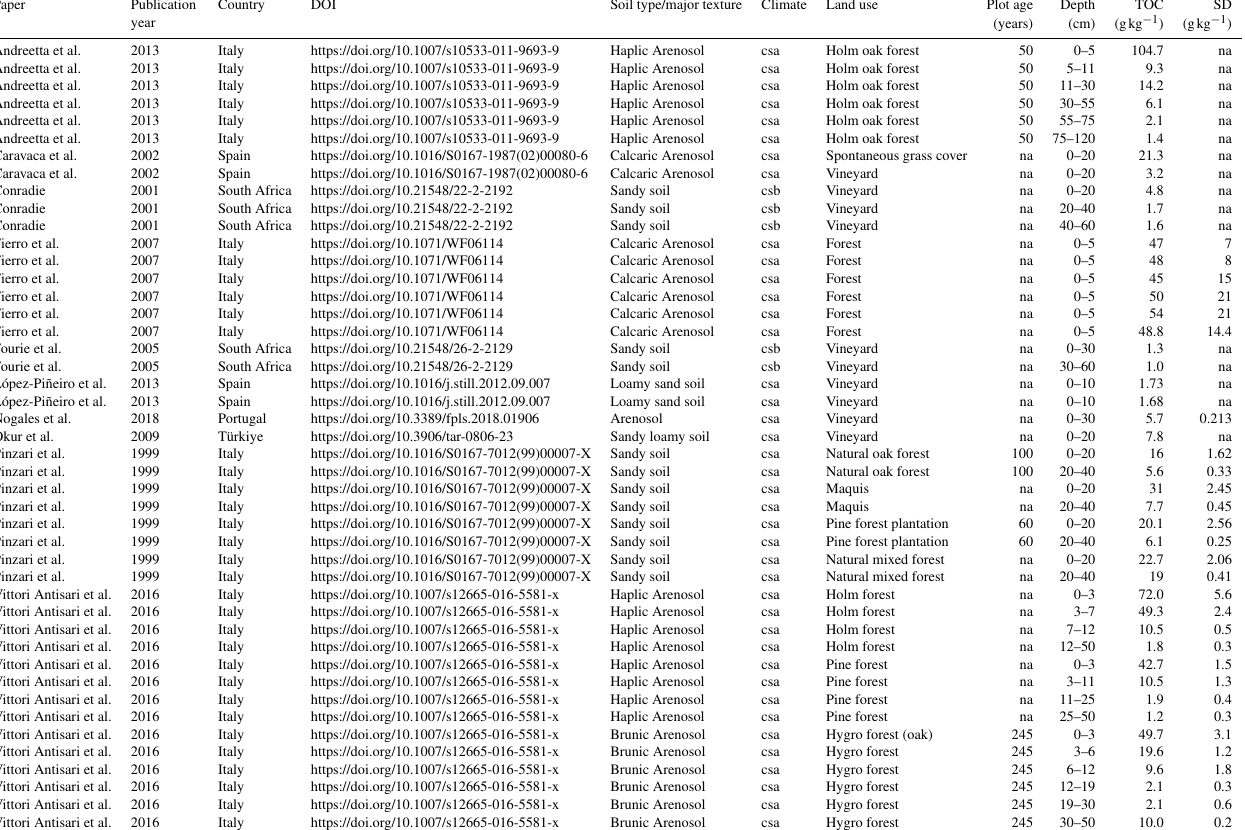
Table E1. Here is a list of the papers used in this study, with land use type for each soil and associated TOC as a function of depth. These papers all deal with Arenosols, or at least sandy soils, in Mediterranean climates according to the Köppen–Geiger criteria (csa means temperate climate and dry and hot summer, and csb means a warm, temperate climate with a warm and dry summer). They were found by accessing the ISRaD database or the Web of Science with the keywords “ 14 C Arenosol